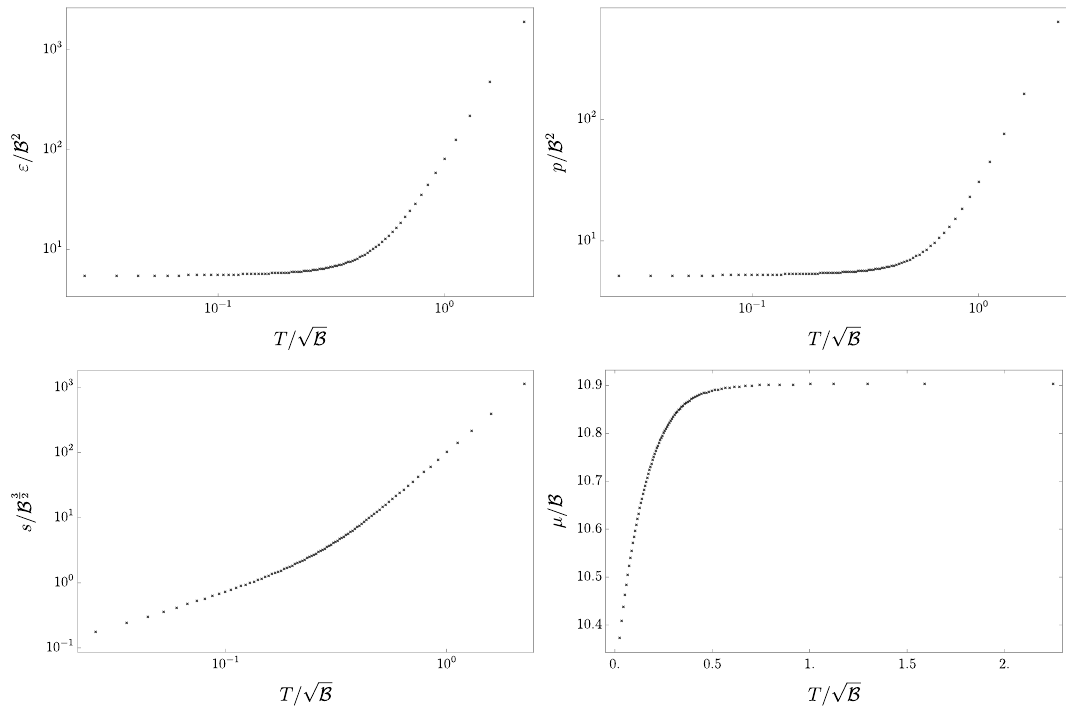
= (2 (cid:25) 2 ), plotted as p c B . The (cid:12)rst three plots use logarithmic scales on